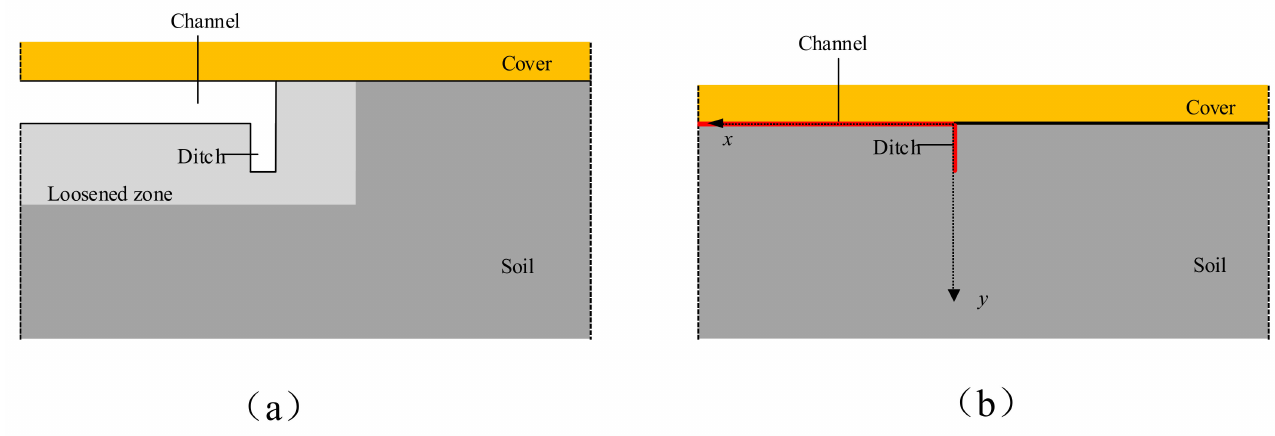
Figure 4. Schematic illustration of: ( a ) the vertical section; ( b ) the simplified vertical section of the channel tip